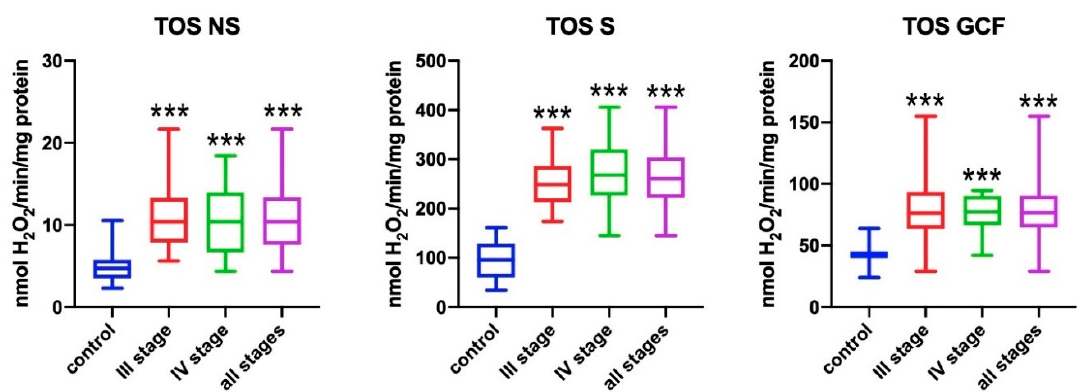
Figure 1. Concentrations of total oxidative status (TOS) in non-stimulated saliva (NS), stimulated saliva (S), and gingival crevicular fluid (GCF) in all patient groups. *** p < 0.001 vs. control group.